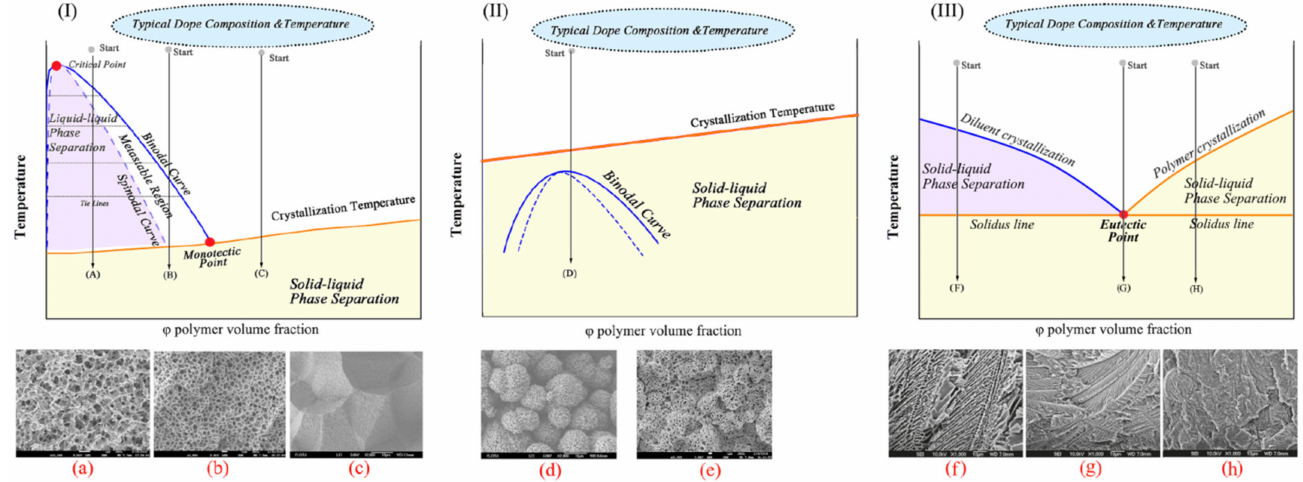
Figure 4. Schematic phase diagrams for the SC polymer mixtures with ( I ) a poor and ( II ) a good liquid solvent and ( III ) eutectic phase diagrams for the SC polymer mixture with a low MW crys- talline substance and typical structures formed as a result of the TIPS of the mixtures with different qualitative and quantitative compositions. Subfigures correspond to the typical morphology of capillary-porous bodies formed due to cooling of the homogeneous mixtures by paths ( a ) A, ( b ) B, ( c ) C, ( d , e ) D, ( f ) F, ( g ) G and ( h ) H. Phase diagrams I and II and the corresponding SEM images were reproduced with permission from Y. Tang, Y. Lin, W. Ma, X. Wang, Journal of Membrane Science; Published by Elsevier, 2021. SEM images ( f – h ) were reproduced with permission from J. Yoon, Alan. J. Lesser, T.J. McCarthy, MACROMOLECULES, 2009, 42, 8827. Copyright year